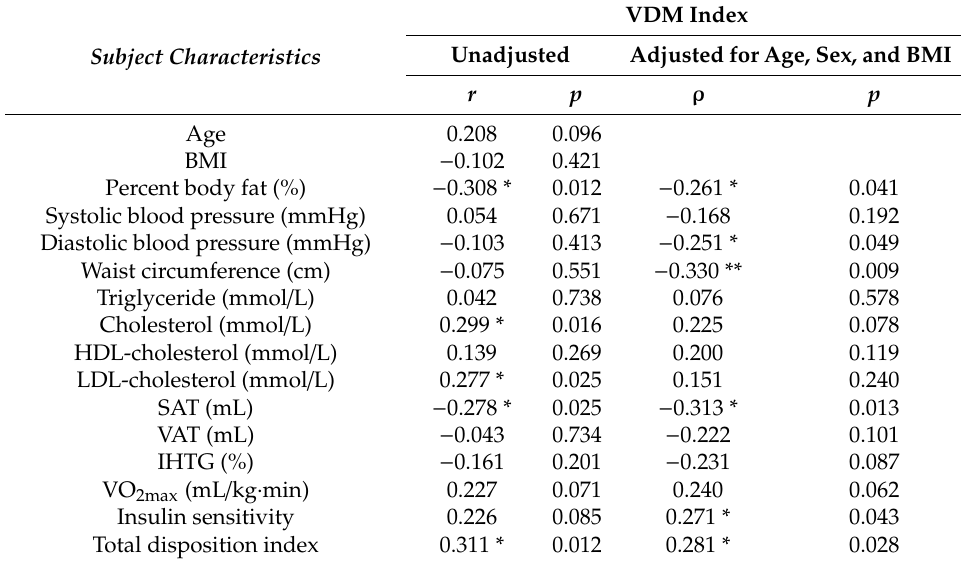
Table 1. Associations between the VDM index and cardiometabolic risk factors in all study subjects ( n = 65).